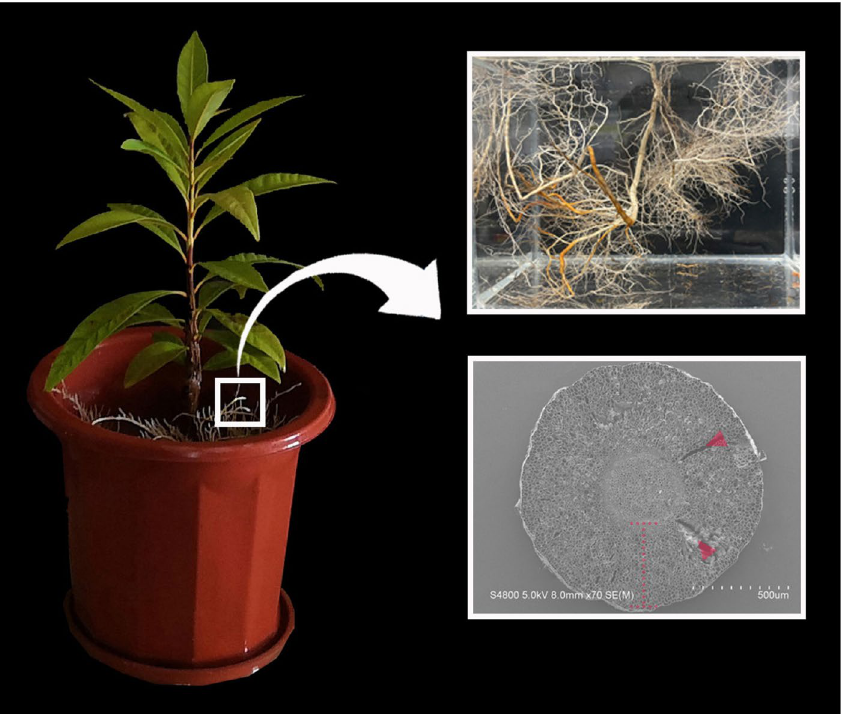
Fig. 2 Compensatory growth in S . nervosum after removing the adventitious root. Note: S. nervosum responds to adventitious root removal by growing a large number of floating roots with aerenchyma from the primary roots. Cortex cell layers and lysigenous aerenchyma are indicated by red dashed lines and red arrowheads,